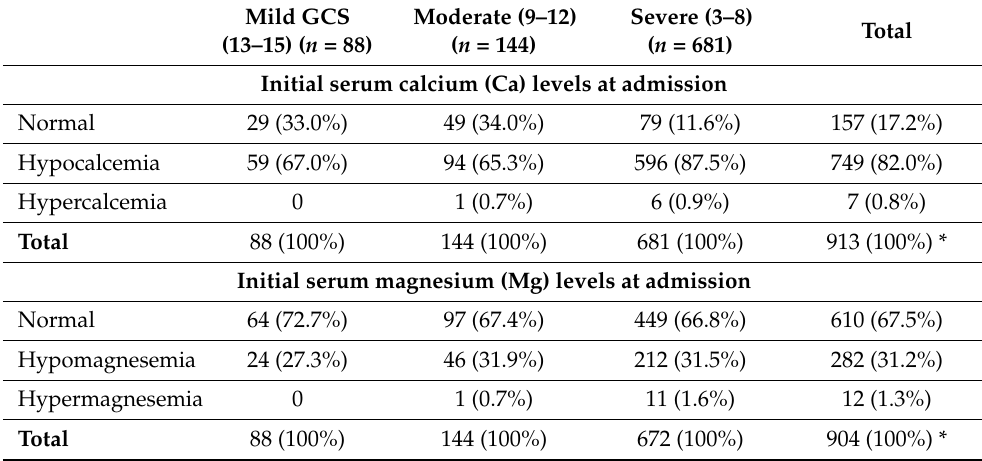
Figure 1. Study flow chart for electrolytes imbalance in TBI patients. Figure 1. study flow chart for electrolytes imbalance in TBI patients. The pattern of serum calcium and magnesium levels by GCS was demonstrated in Table 2. Abnormal calcium levels were very common across all GCS categories, and this was highly prevalent in patients with severe GCS ( p = 0.001). On the other hand, abnormal serum magnesium levels were less prevalent than normal levels in all GCS categories; however, hypomagnesemia was evident in almost one third of each GCS category, and hypermagnesemia was rare. Table 3 demonstrates the levels of serum electrolytes in dif- ferent TBI lesions. SAH was more common in hypocalcemia and hypermagnesemia. Table 2. Calcium and magnesium imbalance in each GCS category in TBI